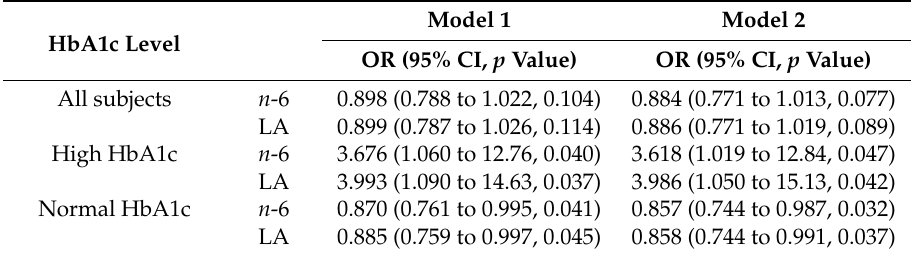
Table 5. Association between n -6 fatty acid intake and hypertension by HbA1c